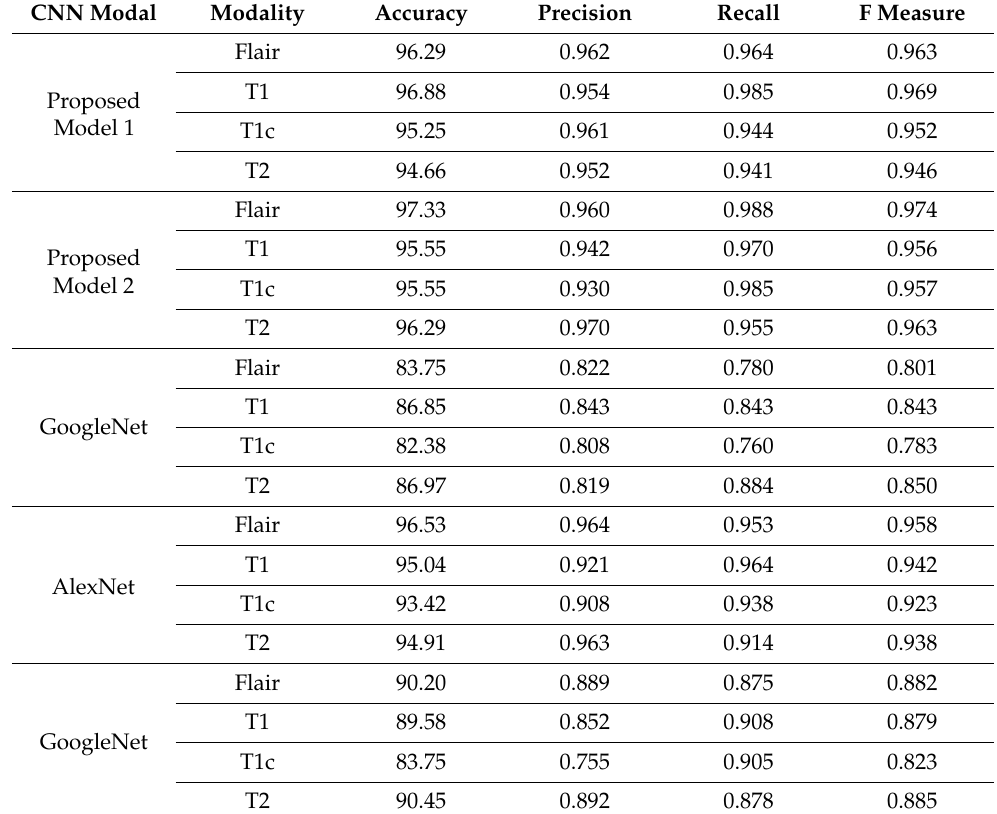
Table 8. Classification results using proposed CNN Models as classifier and comparison with existing CNN models for brain LGG MR